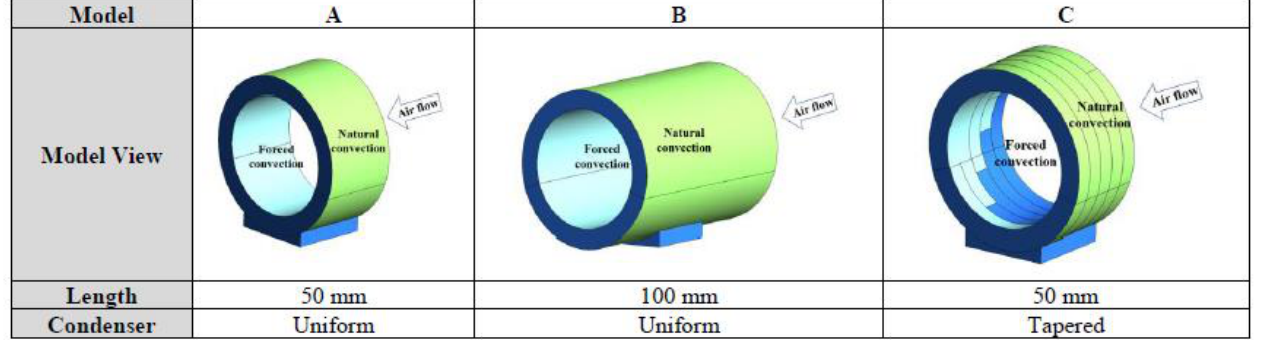
Figure 6. 3D models of concentric annular heat pipe.